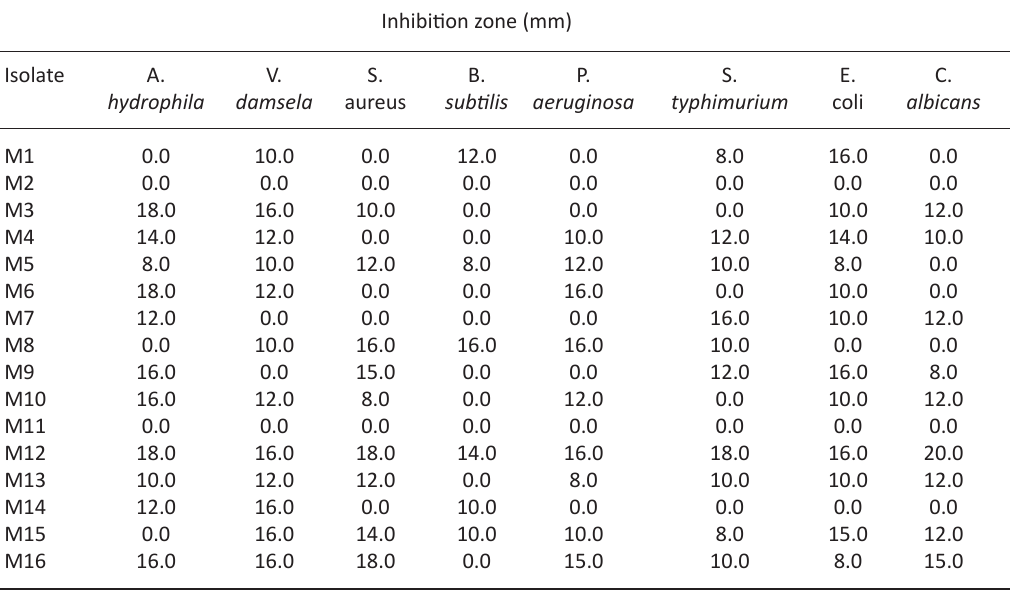
Table 3. Antimicrobial activity of the marine actinomycete isolates